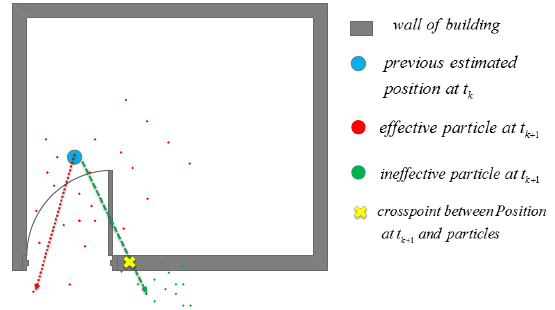
Figure 3 . Fingerprinting-based Wi-Fi positioning Algorithm